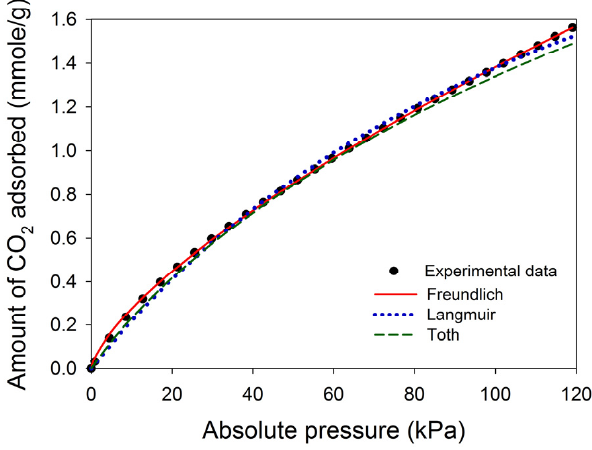
Figure 6. Comparison of the fitted results of three isotherm equations for the adsorption of CO 2 on CN2/ACF at 40 °C. Table 6. Fitted parameters in the Freundlich equation for CO 2 adsorption at different temperatures.